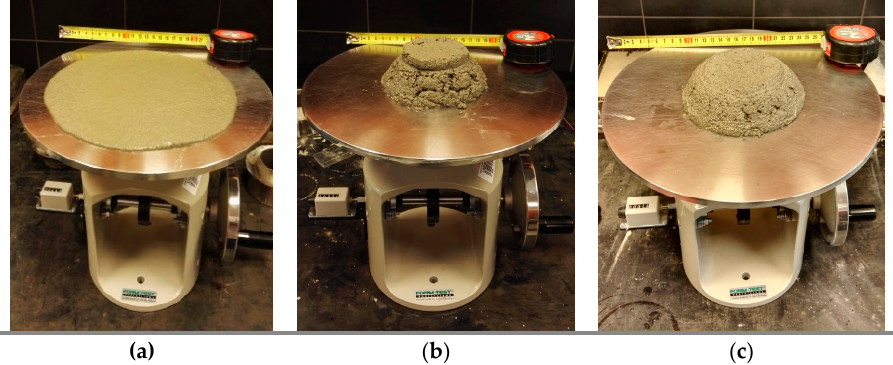
Figure 3. Flow behavior: ( a ) Reference sample (RF); ( b ) Mixture containing 0.5% waste paper fibers (RPC); ( c ) Mixture containing 0.5% waste paper fibers and 0.5% plasticizer (RPCP).